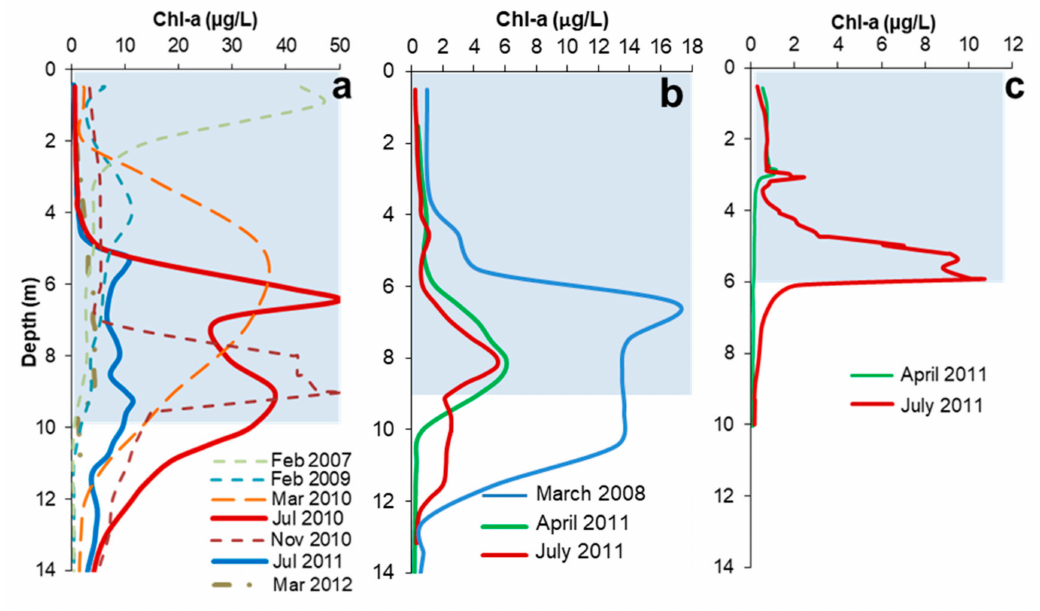
Figure 2. Vertical profiles of chlorophyll-a (Chl-a) concentration across the photic zone of three acidic pit lakes in Southwestern Spain in di ff erent seasons: Cueva de la Mora (a), Herrer í as (b) and San Telmo (c). The three profiles have been set to 14 m for comparison purposes. The photic zone (light blue colored area in the three profiles) varies between these pit lakes (e.g., 6 m in ST vs. 9–10 m in CM and HER; see also Figure 4a for a comparison of PAR